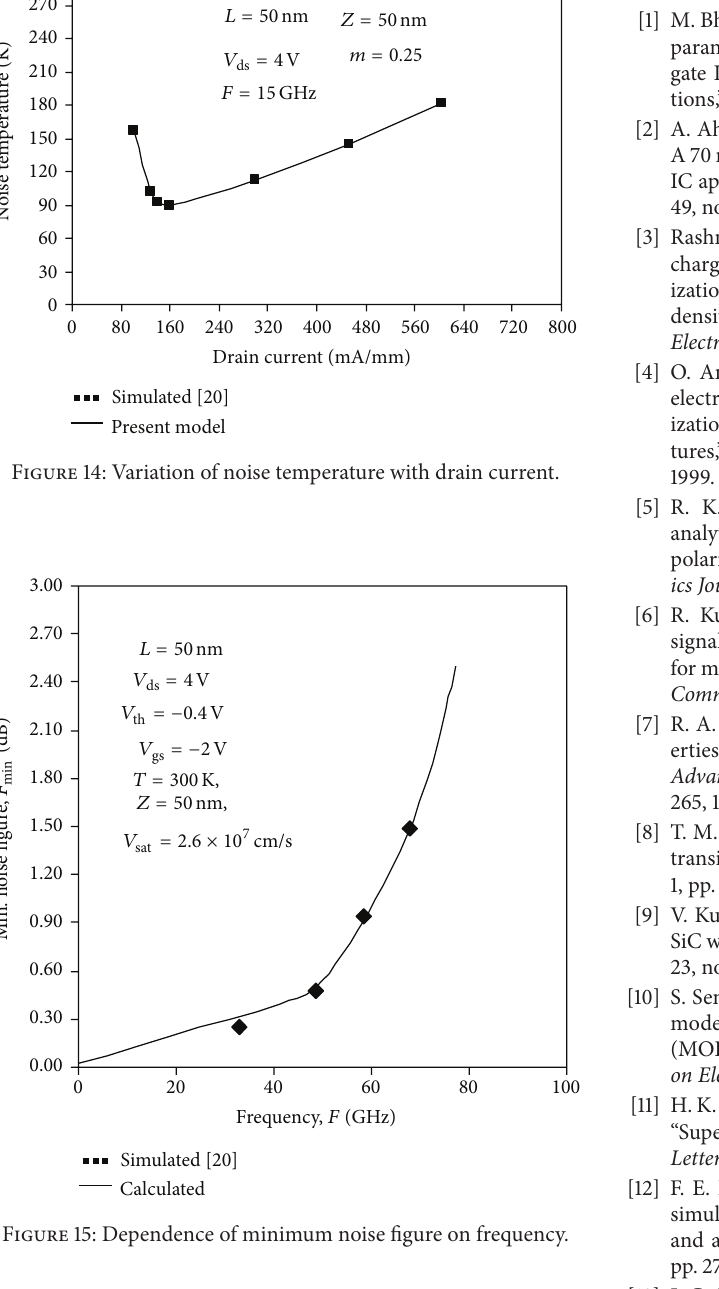
correlation coefficient ( 𝐶 ) and noise figure are also evaluated. The comparisons between the power performance and the model simulation validate the approximations of the present capacitance and noise